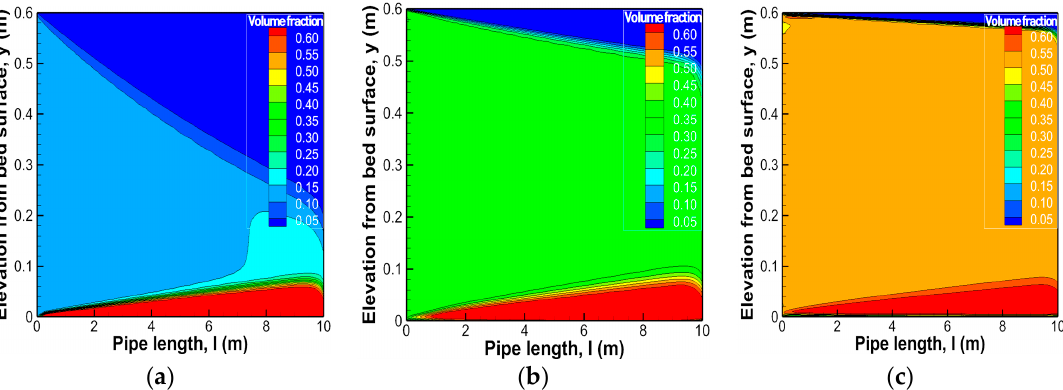
Figure 6. Representative results of numerical modelling of for soil slurry of 0.5 mm particle diameter; ( a ) 1.0 m / s, 10% v / f condition; ( b ) 2.0 m / s, 30% v / f condition; ( c ) 3.0 m / s, 50% v / f